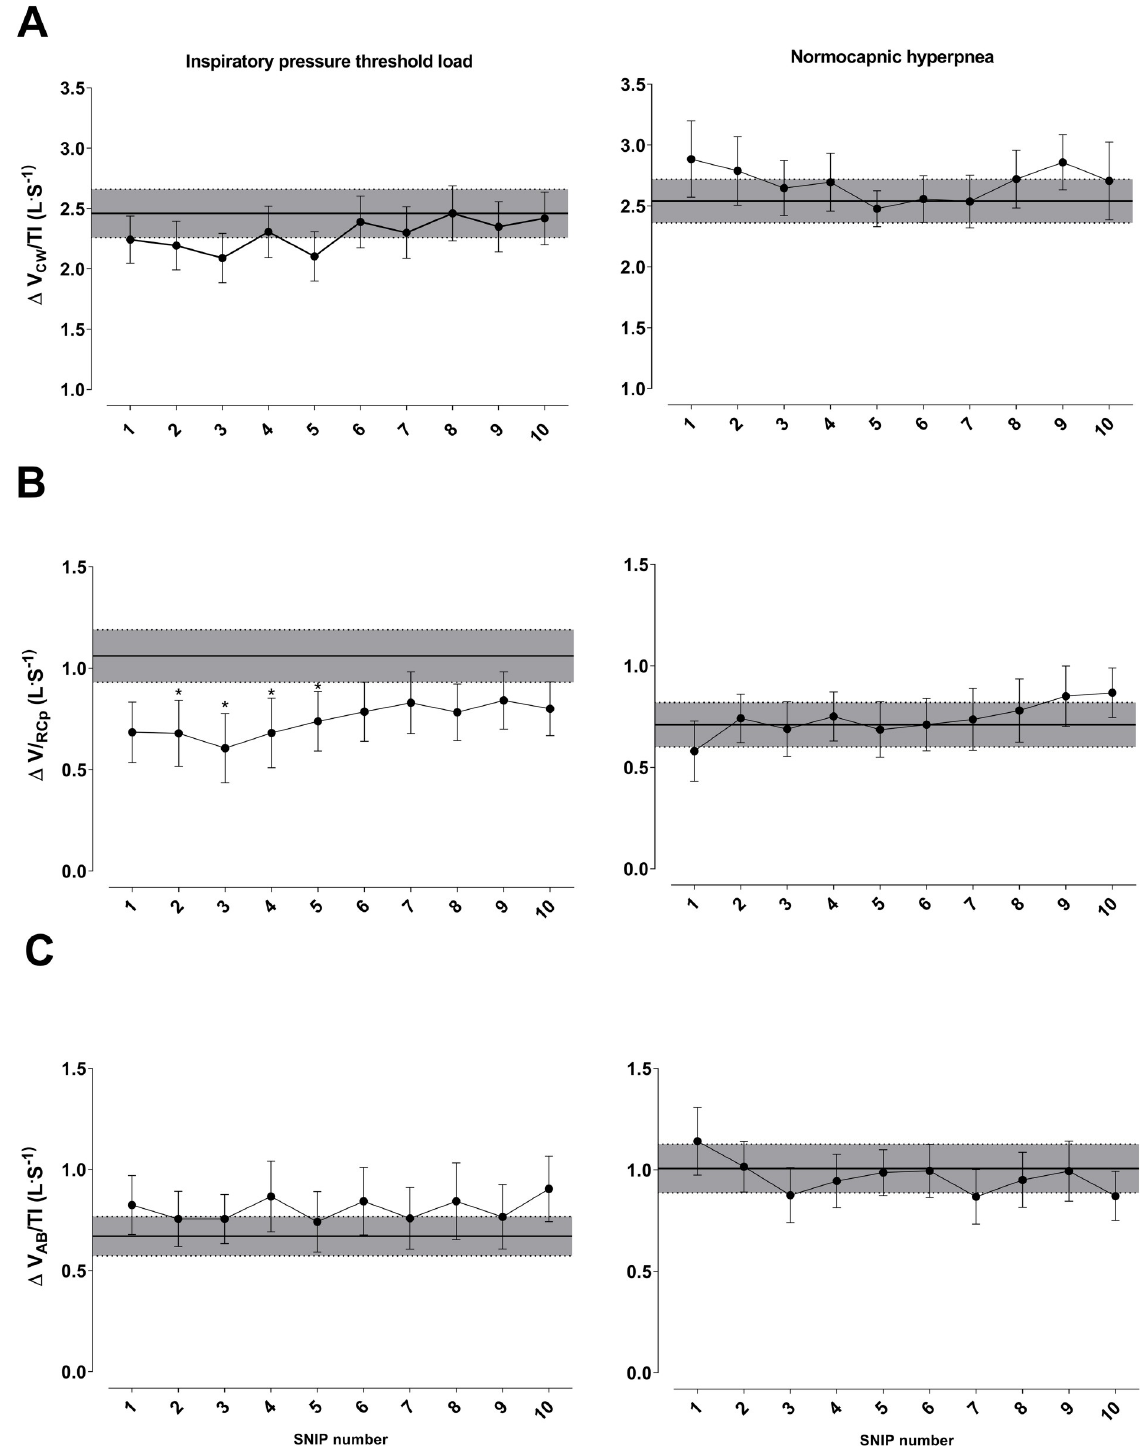
Fig 6. Changes in shortening velocity of global inspiratory muscles ( Δ V CW / Ti- panel A), inspiratory rib cage muscles ( Δ V RCp / Ti- panel B), and diaphragm ( Δ V AB / Ti- panel C). Comparison of values during recovery of endurance test and pre-test (gray band). Data presented as mean ± SE. Abbreviation: L.s -1 : liters per second. � Statistically significant intragroup difference between pre-test and recovery p < 0.05.